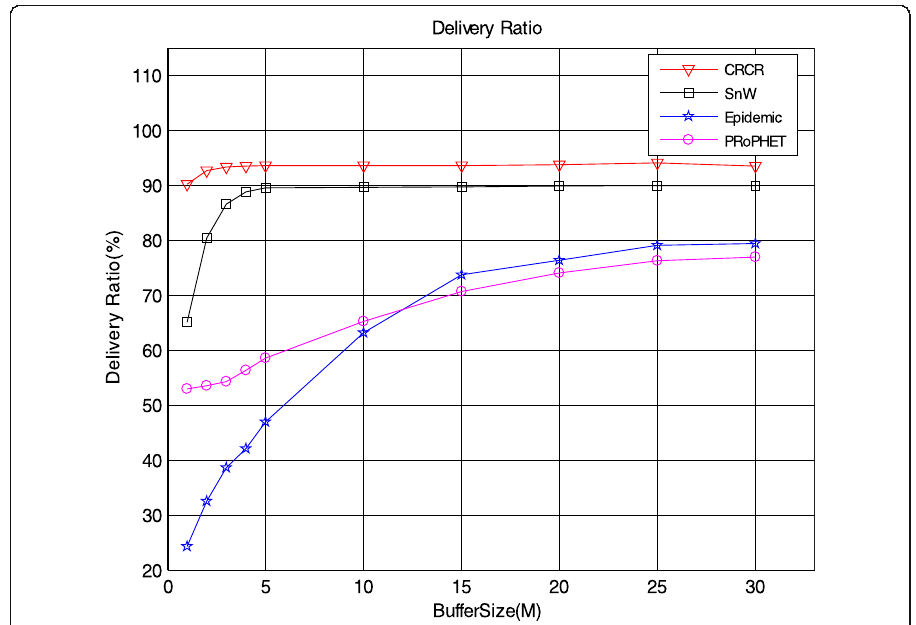
Fig. 2 Virtual machine placement target optimization training sample set